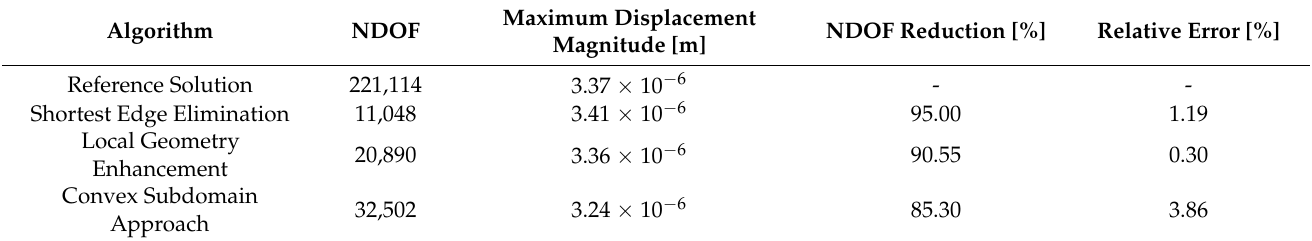
Table 2. Comparison of the results obtained for different algorithms (linear elasticity